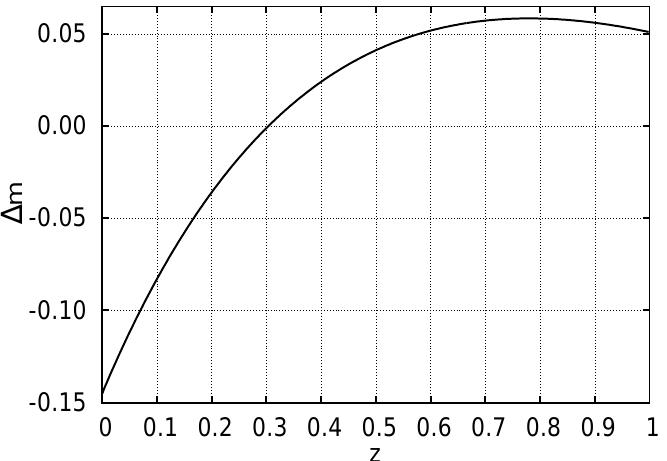
Fig. 1b. The ratio of the luminosity distances for the above described flat and hyper- bolic model universes. The difference is quite small and apparently not distinguishable by